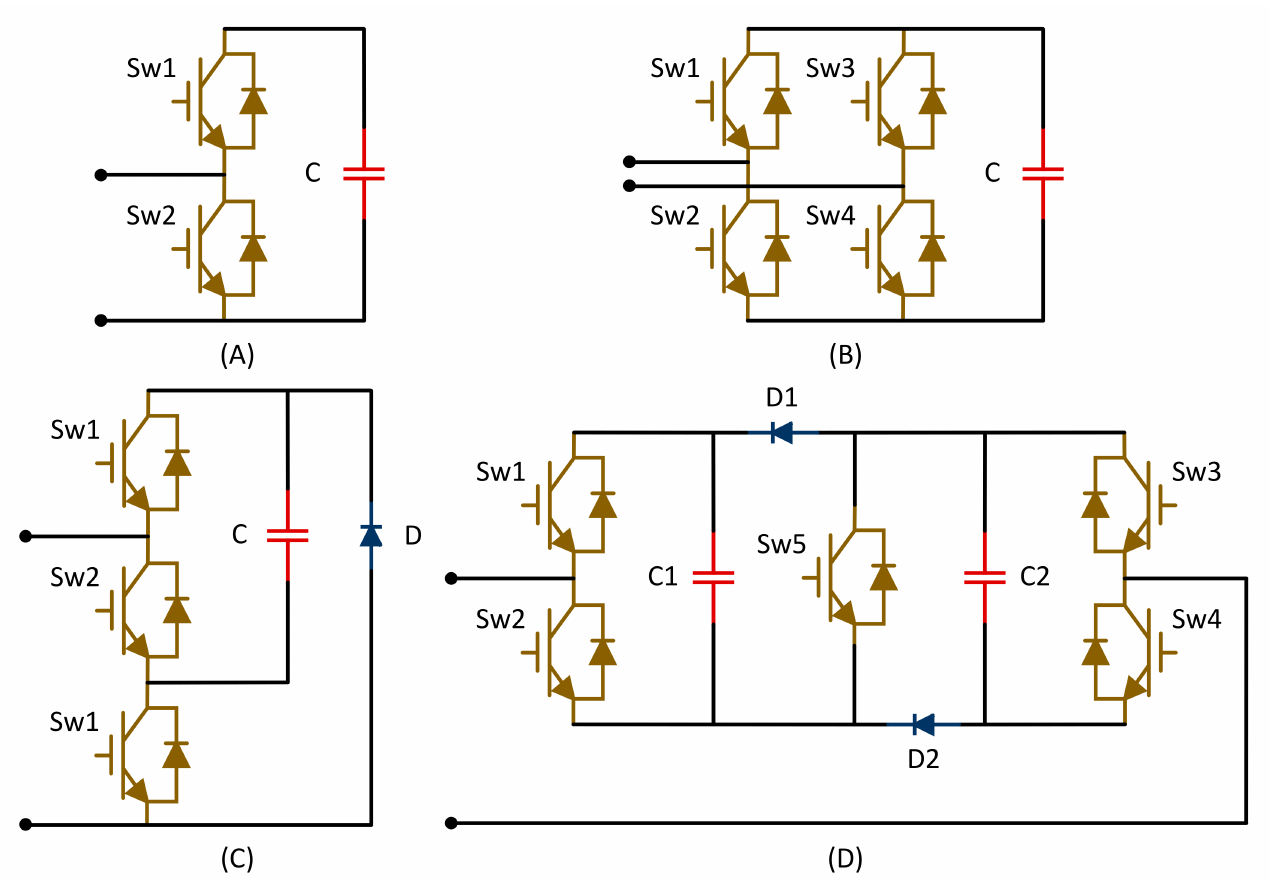
Figure 8. Topologies of sub modules ( A ) half-bridge, ( B ) full-bridge, ( C ) single clamped, and ( D ) double